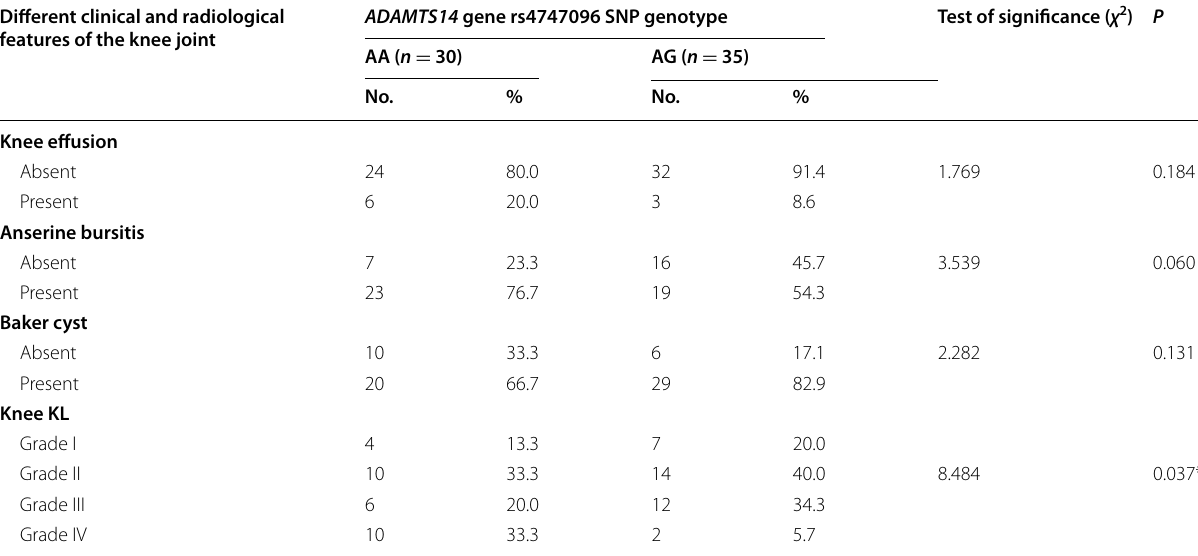
ADAMTS a disintegrin and metalloproteinase with thrombospondin motifs, KL Kellgren-Lawrence scale, No. , n number of patients, P P value for comparing between AA and AG, SNP single nucleotide polymorphism, χ 2 Value of the chi-square test, % percentage of patients *Statistically significant at P ≤